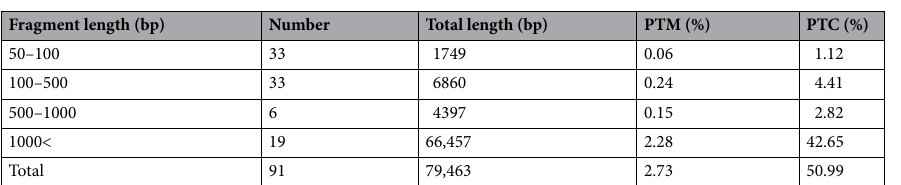
Table 5. Summary of the transfer of sequences from chloroplast to mitochondrial genomes in C. melo. PTM Percentage of transferred sequences in mitochondrial genome, PTC percentage of transferred sequences in chloroplast